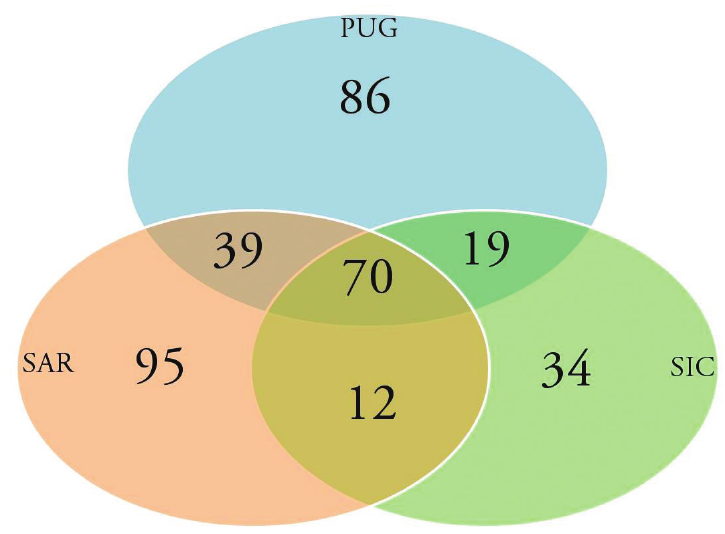
Figure 9. Venn diagram with food taxa used in Apulia, Sicilia and